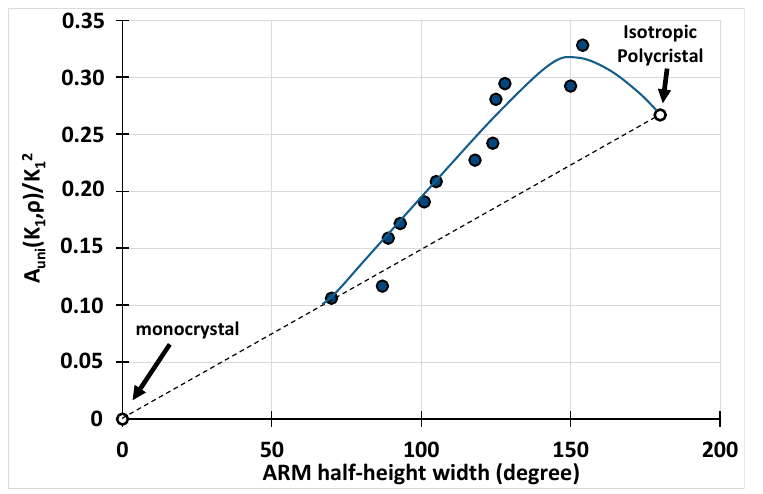
(cid:4666)𝐾 , 𝜌(cid:4667)/𝐾 (cid:2869)(cid:2870) as a function of the ARM half ‐ height width (the full line is as a function of the ARM half-height width (the full line is (cid:3048)(cid:3041)(cid:3036) (cid:2869) 1